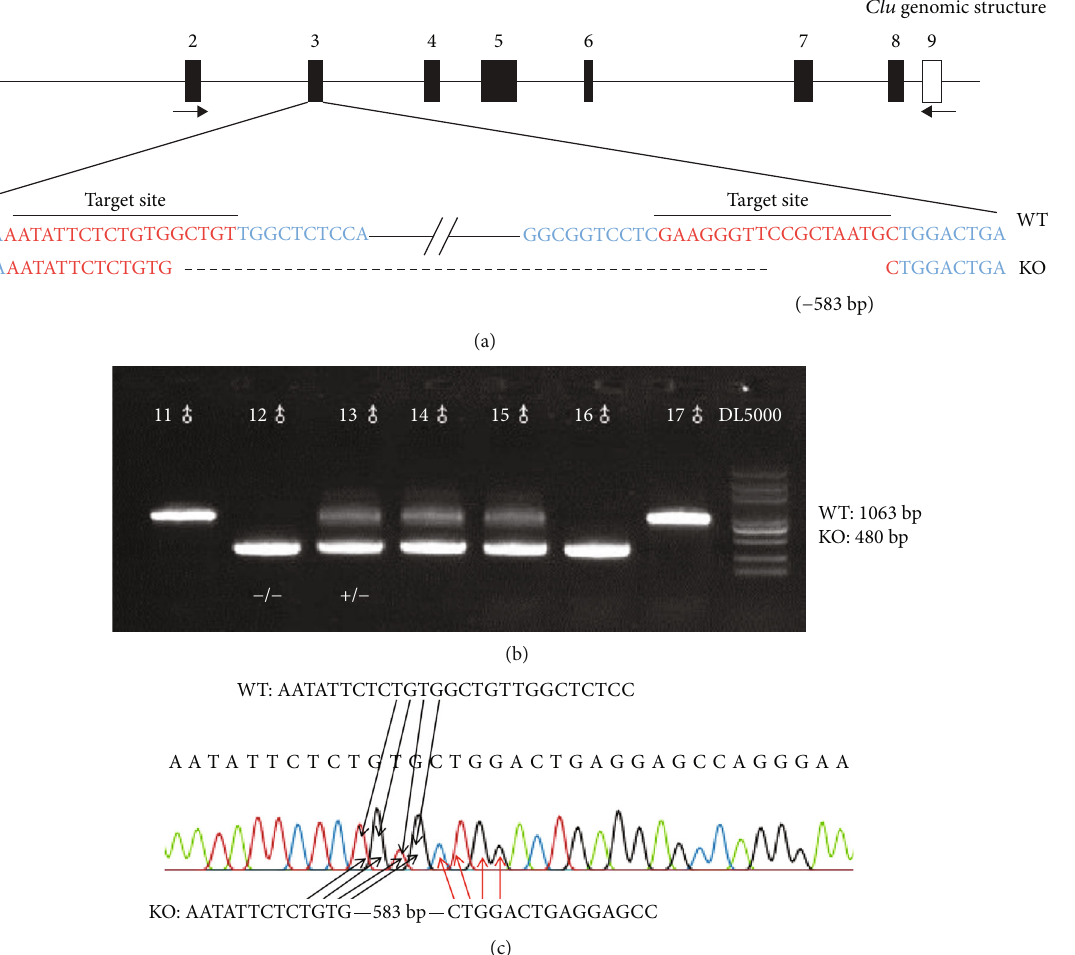
Figure 1: Construction of Clu knockout mice. (a) Schematic drawing showing the strategy used for Clu gene disruption. The target sites of clustered regularly interspaced short palindromic repeat (CRISPR)-Cas9 small guide RNAs (sgRNAs) in the Clu gene are indicated in red, and the deleted region of the Clu gene in knockout mice is indicated by dashes. The positions of RT-PCR primers are indicated by arrows. (b) PCR products were separated on a 1.5% agarose gel, and the expected band sizes for WT and knockout (KO) alleles were 1,063 and 480 bps, respectively. (c) Sequencing results for homozygotes. The black arrows represent wild-type sequences, and the red arrows represent sequences following the deleted